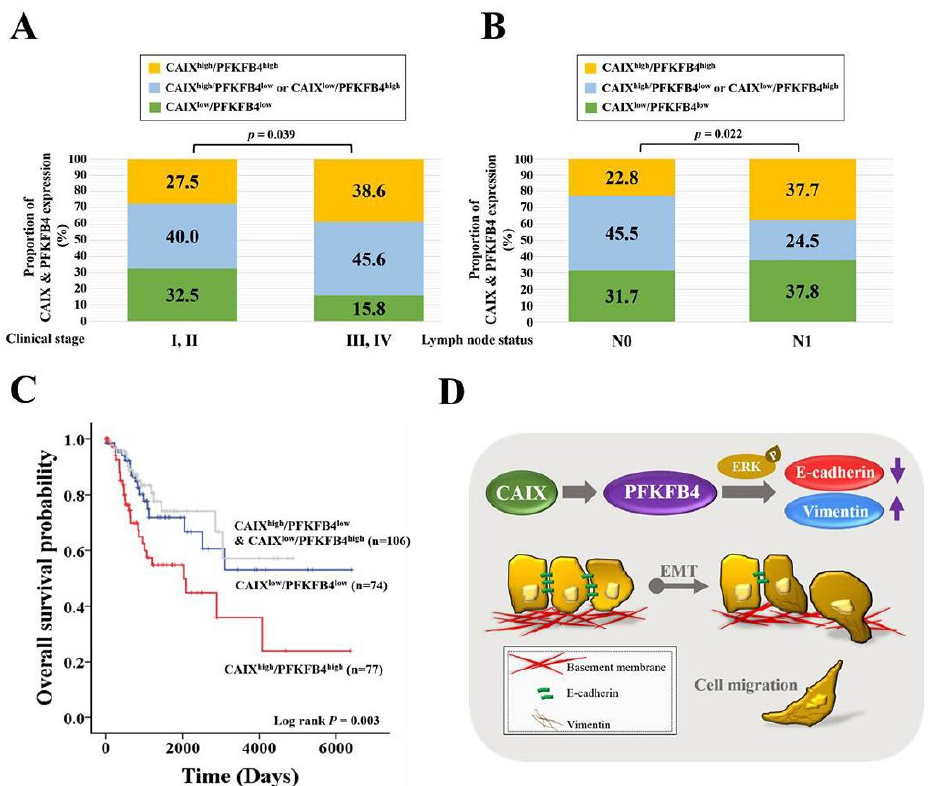
Figure 5. Clinical late-stage and lymph node metastasis are with CAIX high /PFKFB4 high in cervical cancer patients. ( A ) The association of the combined expression of CAIX and PFKFB4 with the clinical stage (I–IV) or ( B ) lymph node metastasis (N0–N1) in patients with cervical cancer patients. Grouped by CAIX high /PFKFB4 high , CAIX high /PFKFB4 low or CAIX low /PFKFB4 high , and CAIX low /PFKFB4 low . ( C ) Kaplan–Meier curves for overall cervical cancer patient survival, grouped by CAIX high /PFKFB4 high , CAIX high /PFKFB4 low or CAIX low /PFKFB4 high , and CAIX low /PFKFB4 low . ( D ) Schematic summary of the CAIX-PFKFB4-EMT signaling pathway.